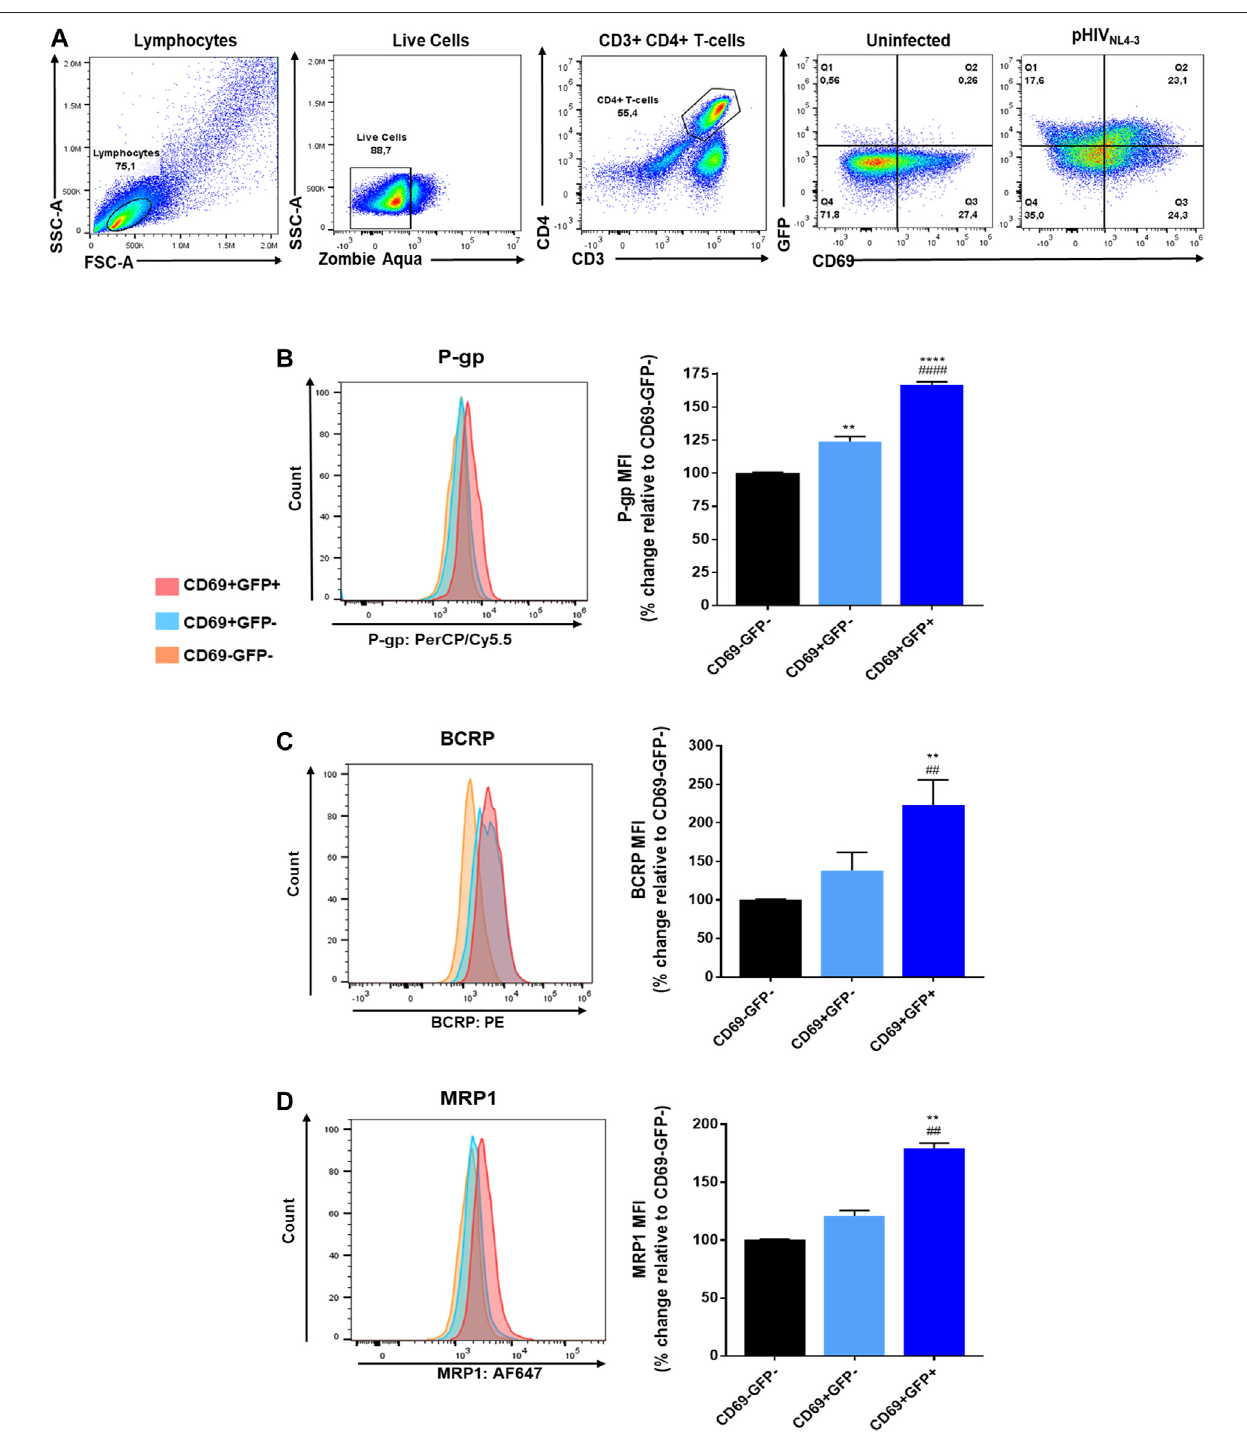
FIGURE 2 | Expression of P-gp, BCRP and MRP1 in pHIV NL4-3 activated CD4+ T-cells. pHIV NL4-3 in cells is demonstrated by the expression of GFP (GFP+). (A) Representative gating strategy for CD4 + T-cells isolated from PBMCs exposed to pHIV NL4-3 or untreated control; panels from left to right show lymphocytes selected based on light scattering properties, viable (negative for Zombie Aqua) single cells were then selected for CD3 + CD4 + expression, then the expression of CD69 and/or GFPwasdeterminedinCD4 + T-cells. (B – D) Resultsareshownasmeanpercentchange ± SEMintheexpression(median fl uorescenceintensity,MFI)ofeachABC transporter in activated cells without the virus (CD69+GFP-), or activated cells carrying pHIV NL4-3 (CD69+GFP+), compared to their expression levels in control non- activated (CD69-GFP-) cells. Left panels show representative histograms corresponding to bar charts on the right. Statistical analyses were performed using one-way ANOVAwith Bonferroni ’ smultiple comparisons test. *, statistically signi fi cant difference compared toCD69-GFP- cells; #, statistically signi fi cant difference compared to CD69+GFP- cells, n (cid:2) 3 donors. **, p < 0.01; ****, p < 0.0001; ##, p < 0.01; ####, p < 0.0001.